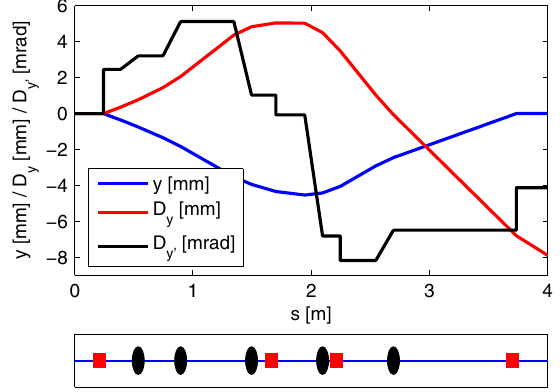
FIG. 3. Vertical dispersion generation with an orbit bump. The upper plot shows the calculated vertical trajectory and dispersion functions through the orbit bump. The lower plot shows a sketch of the lattice: the black ellipses indicate the quadrupole magnets and the red rectangles correspond to the vertical corrector magnets.